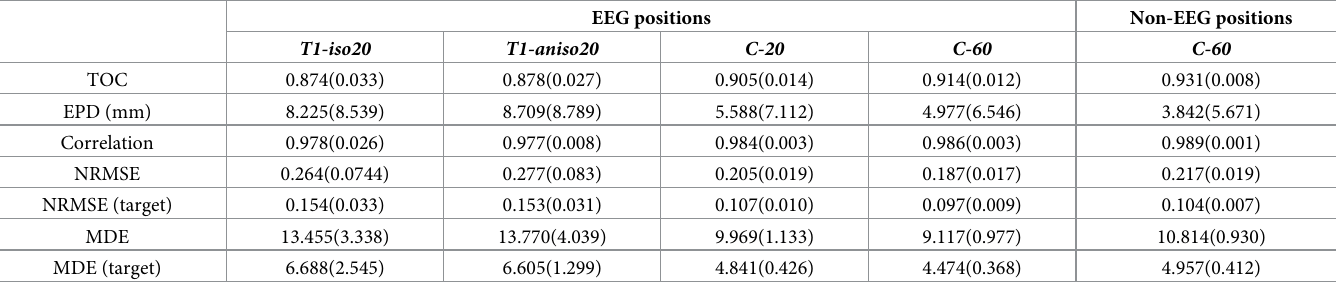
Table 2. Performance of the models using independent HCP datasets.